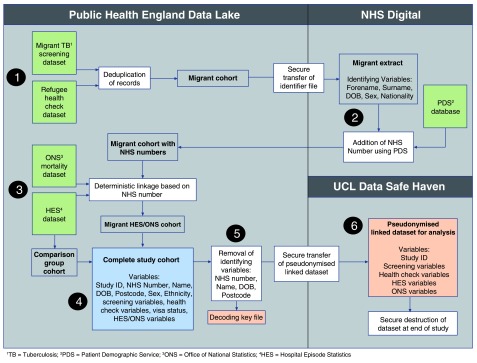
Study data flows.